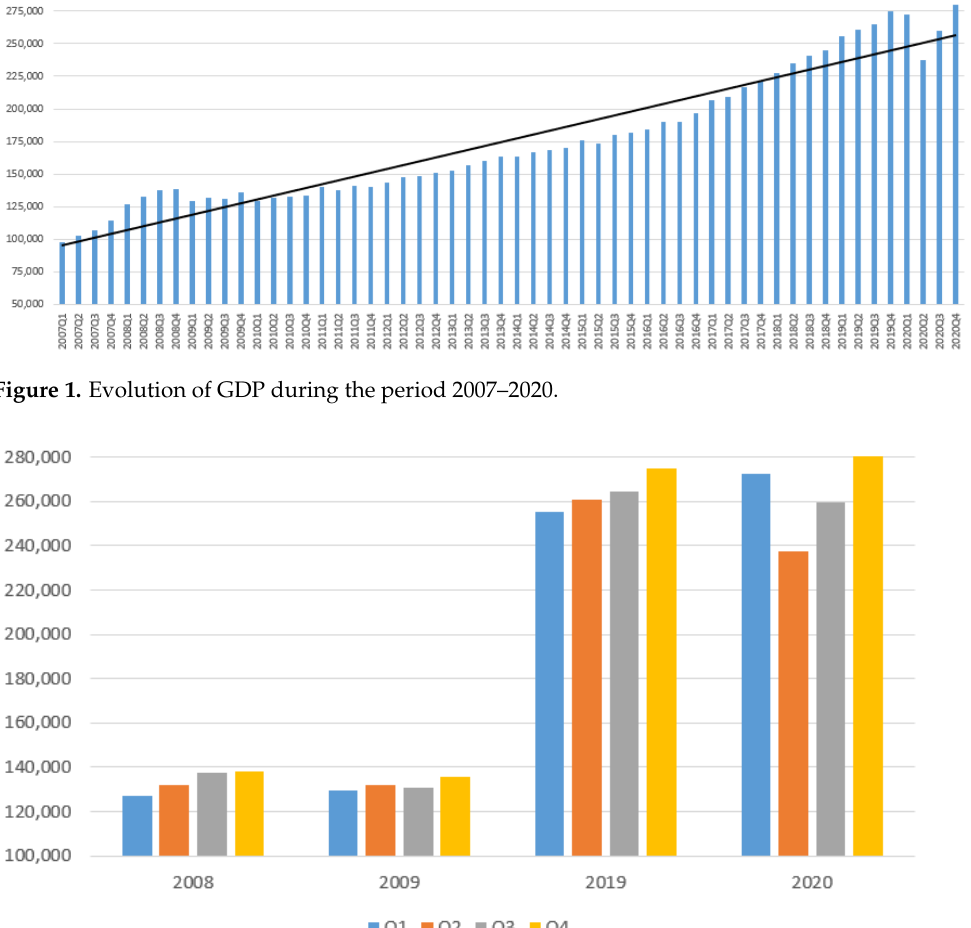
Energies 2021 , 14 , x FOR PEER REVIEW 10 of 27